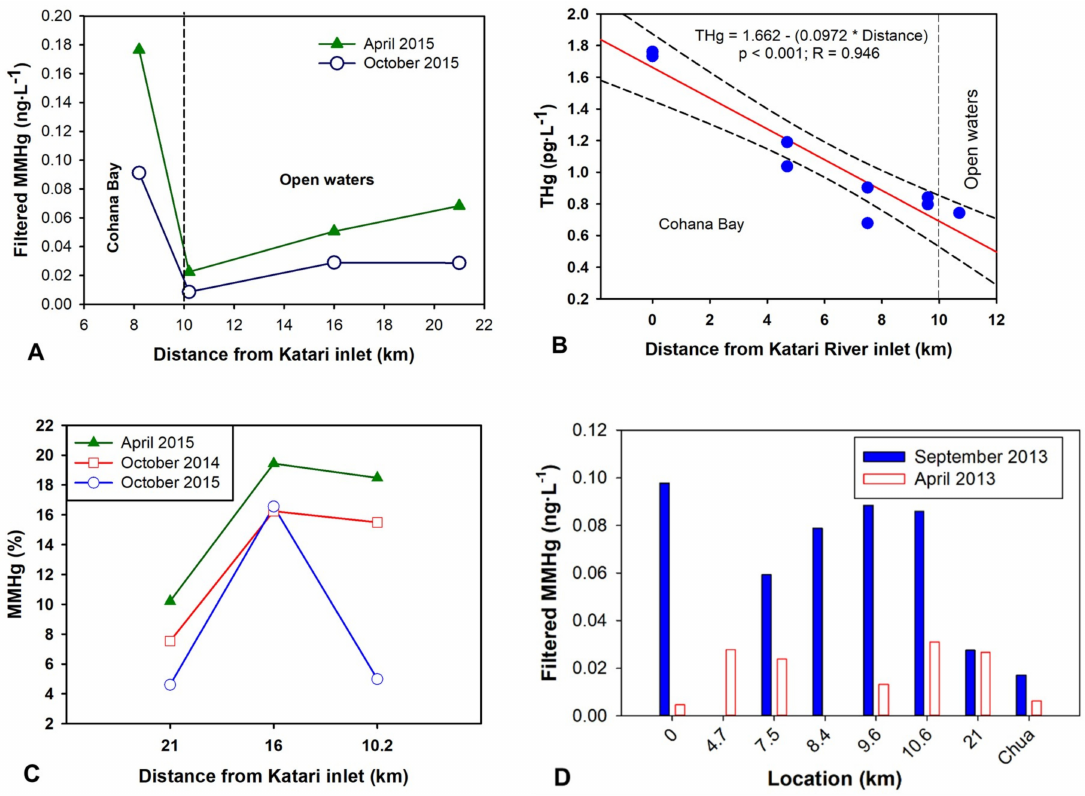
Figure 5. ( A ) Methylmercury concentrations in filtered water (MMHg) in the, 21, 16, and 10.2 km sampling locations during and after the algae bloom. ( B ) Total mercury (THg) measured at different distances from Katari River inlet to the lake. ( C ) Percentage of methylmercury in filtered water. ( D ) Methylmercury concentrations in two distinct seasons before the